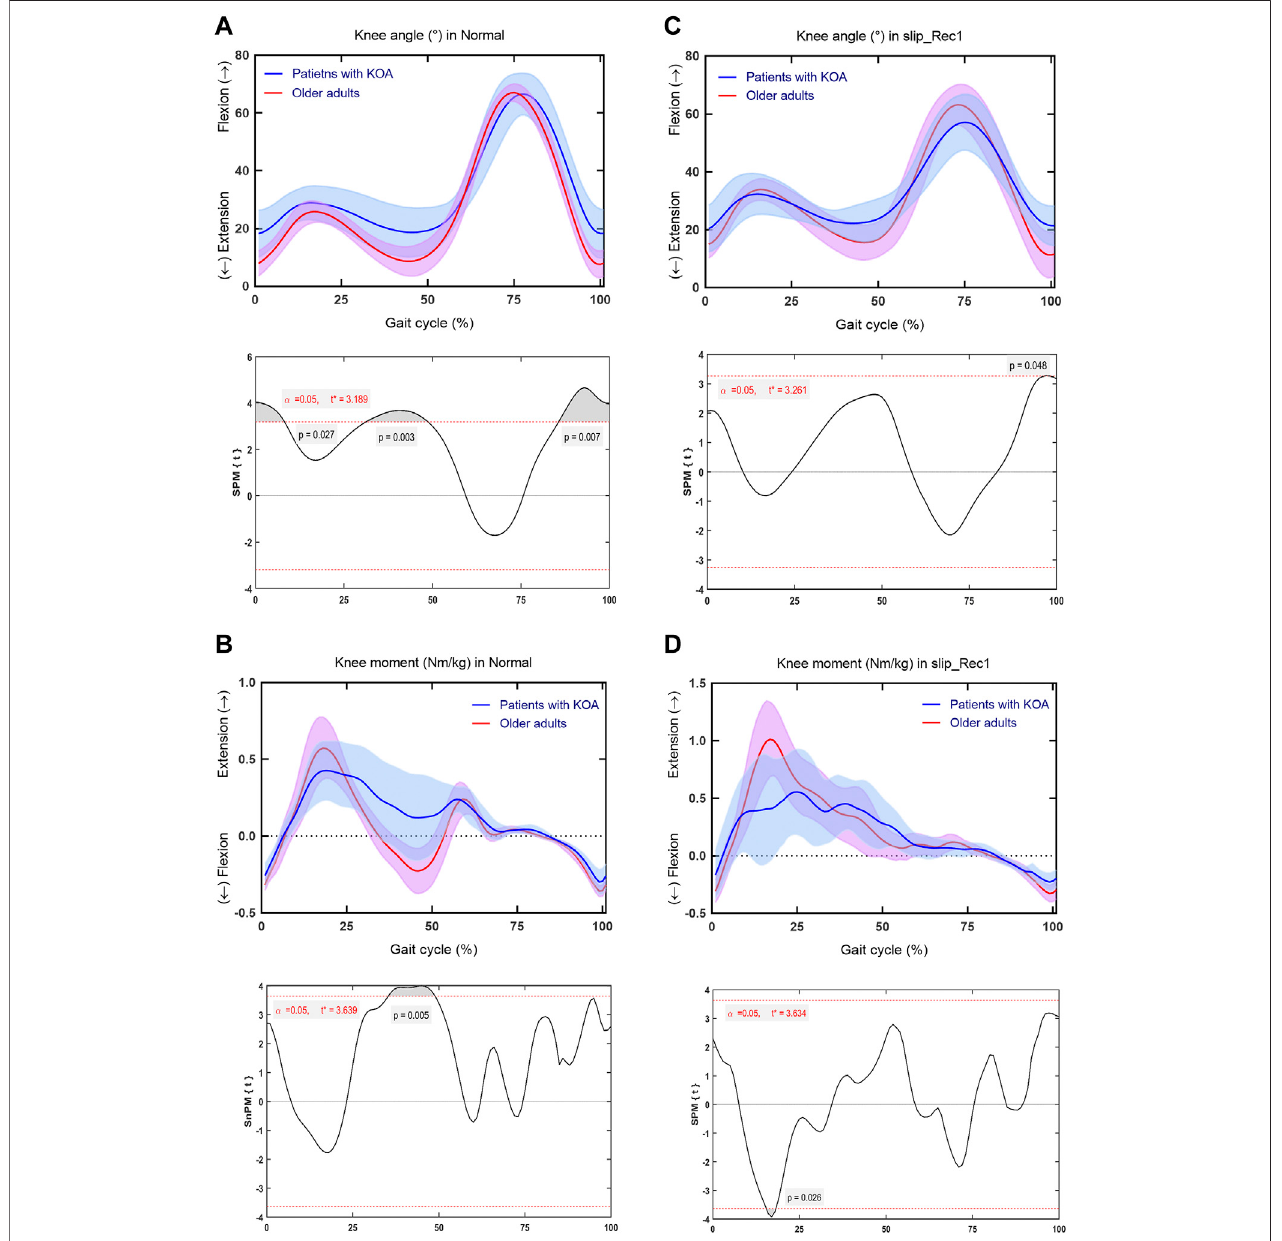
FIGURE 6 | Comparison between patients with knee osteoarthritis (KOA) and older adults for the knee angle and knee moment in Normal and slip_Rec1 in the sagittalplane.KneeangleforpatientswithKOAandolderadultsinNormal (A) ,kneemomentforpatientswithKOAandolderadultsinNormal (B) ,kneeangleforpatients with KOA and older adults in slip_Rec1 (C) , and knee moment for patients with KOA and older adults in slip_Rec1 (D) . The upper and lower panels present the average andstandarddeviationofpatientswithKOAandolderadultsandthecorrespondingoutcomes oftheone-dimensionalstatisticalparametricmapping(SPM)scalar trajectory t -test, respectively. Foreach analysis, thesigni fi cance level isset at 0.05, and the correspondingt*ispresentedasthe horizontal red dashed line.The p values associated with the supra-threshold clusters, denoted as the grey shaded regions, are presented whenever the test statistic continuum SPM{t} or SnPM{t} exceeds the